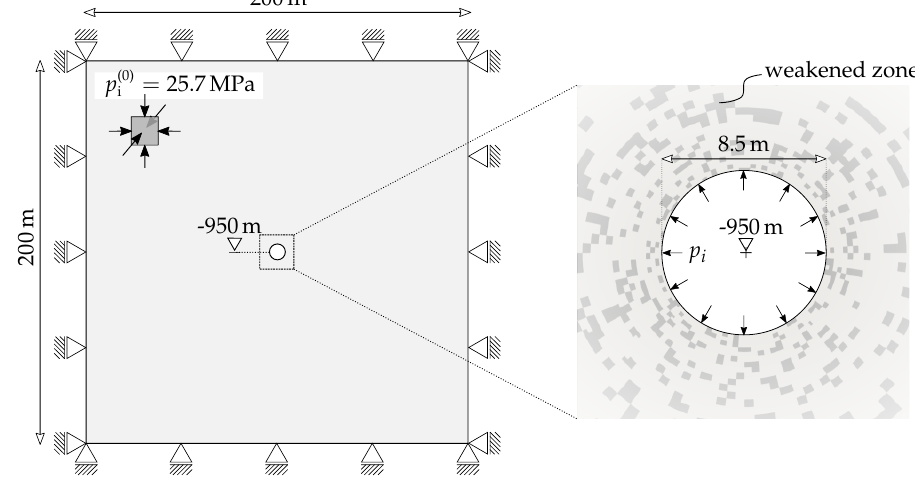
Figure 14. 2D initial boundary value problem of deep tunnel excavation: full model ( left ) and the detail center view ( right